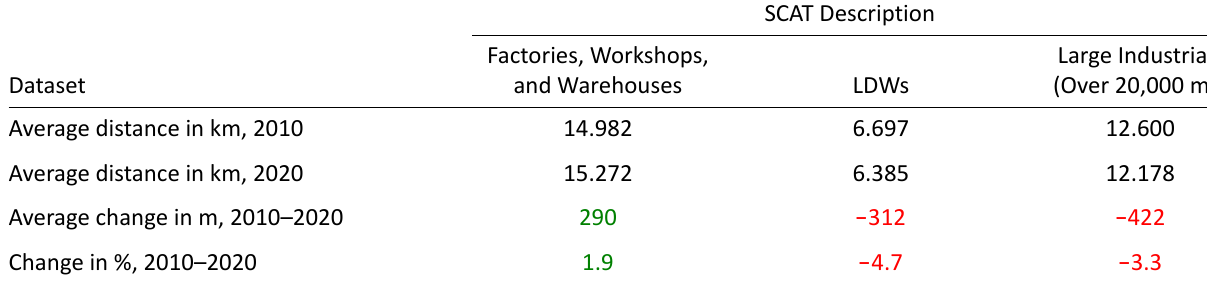
Table 3. Distance (m) to MJ by category, 2010–2020.